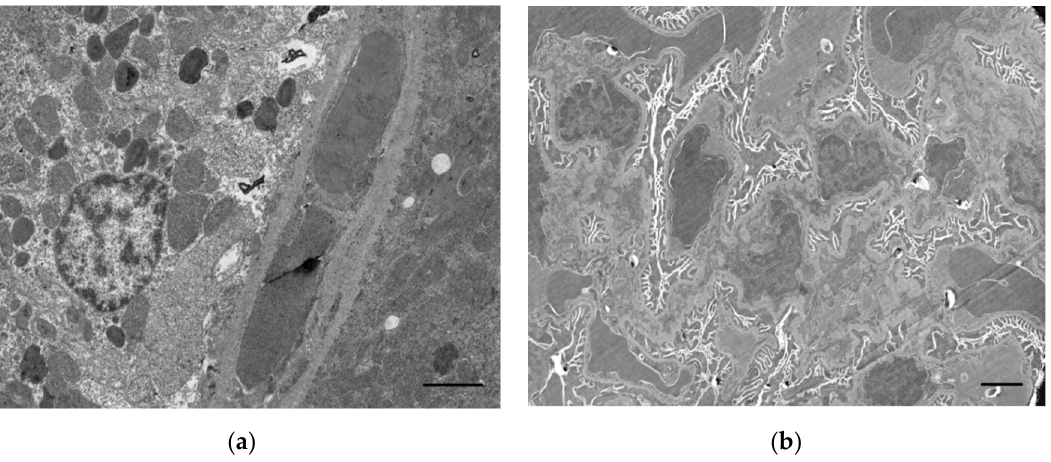
Figure 3. Ultrastructural changes in the kidney of a rat that died due to acute paraoxon poisoning at a dose of LD84. ( a ) Stasis in the blood capillaries of the interstitium and preservation of the mitochondria of the tubular epithelial cells; ( b ) spastic contraction and stasis in the glomerular capillaries of the renal cortical layer. Scale bar = 2 μ m.